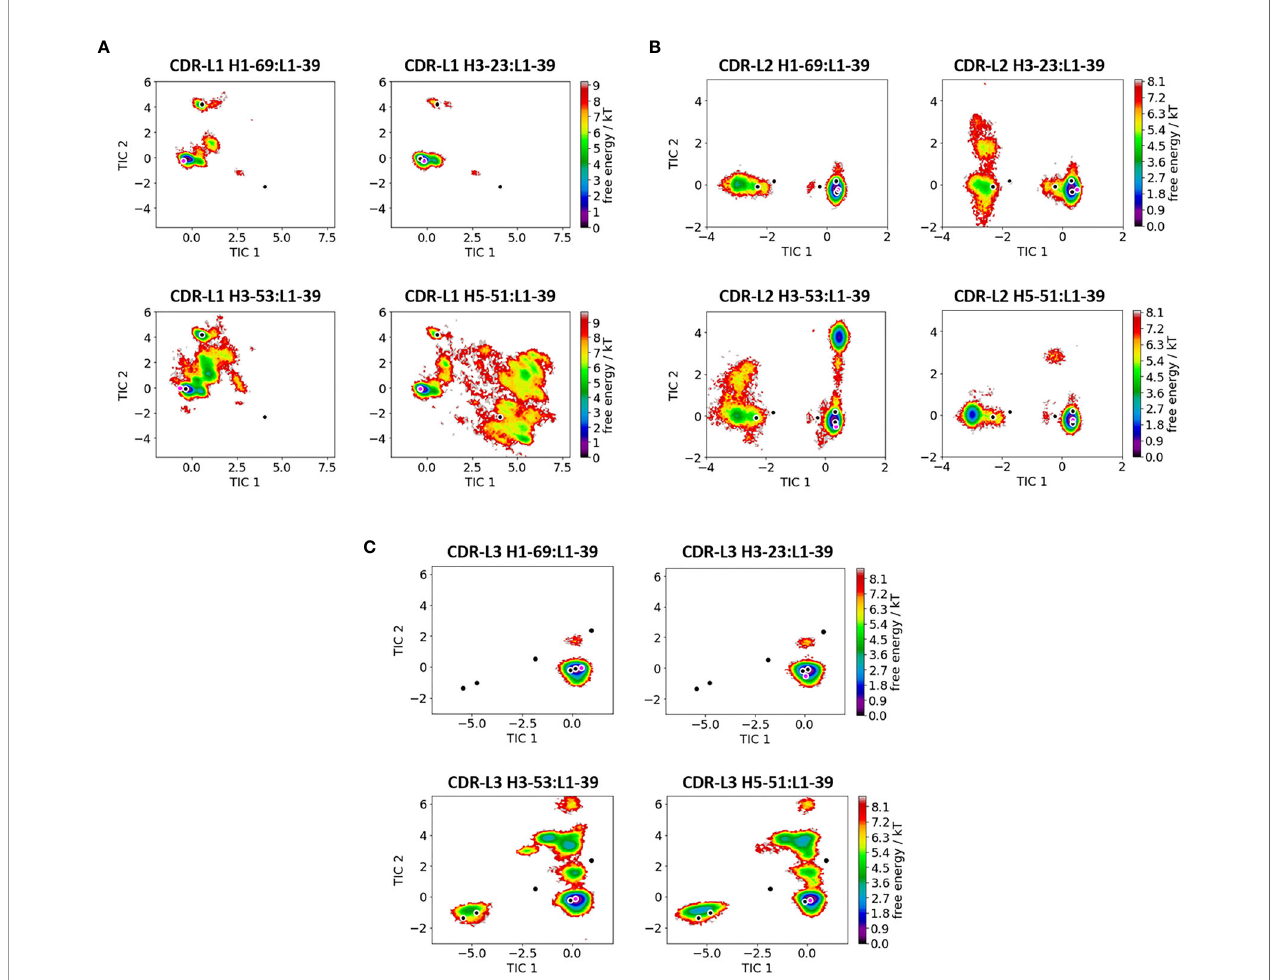
FIGURE 2 | Comparison of all V L -CDR loops consisting of the heavy chain germline L1-39. (A) Shows the free energy surfaces of the CDR-L1 loop paired with different heavy chain germlines in the same coordinate system. The available canonical cluster structures for the CDR-L1 loop of length 11 are projected into the free energy surface and are depicted in black. In pink the respective crystal structures, which were used as starting structures are illustrated (PDB accession codes: 5I15, 5I19, 5I1E and 4KMT). (B) Displays the resulting free energy landscapes for the CDR-L2 loop projected into the same coordinate system. The canonical cluster structures of the CDR-L2 loop of length 8 are projected and illustrated in black. The pink dot represents the starting X-ray structures for the simulations. (C) Shows the free energy landscapes of the CDR-L3 loop. The canonical cluster representatives of the CDR-L3 loop, consisting of 9 residues, are projected into the free energy surfaces and colored in black. The pink dot shows the CDR-L3 loop starting structure for the